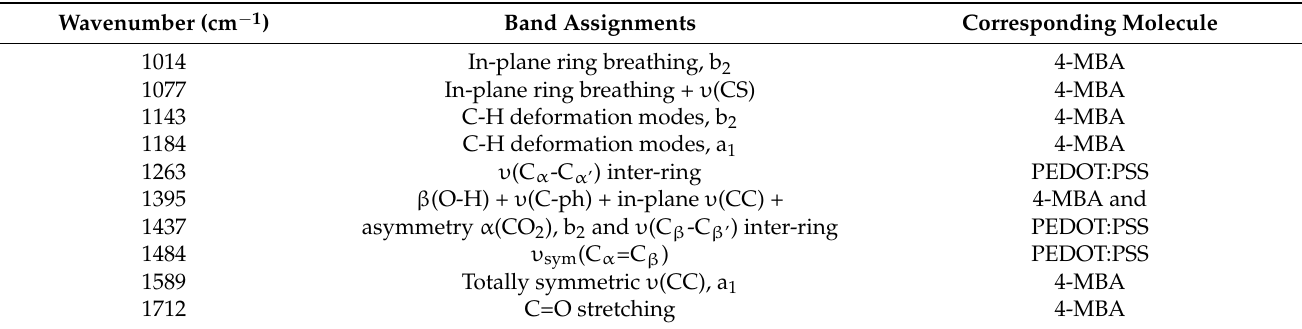
Table 1. Band assignments for the spectrum of 4-MBA in the Ag/4-MBA/PEDOT:PSS composite system under 633 nm